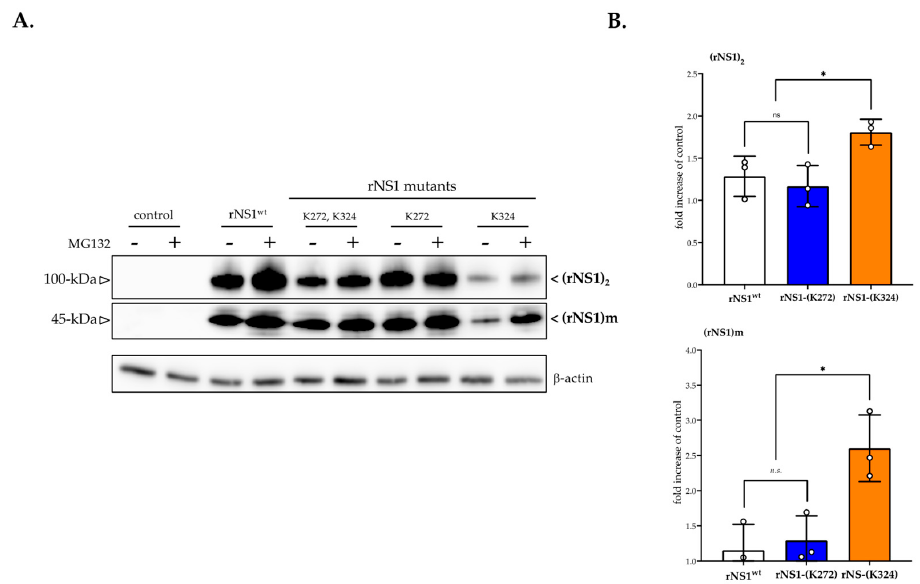
Figure 3. Effect of proteasome inhibition on DENV-2 rNS1 expression. Huh7 cells were transfected for 24 h with plasmids expressing DENV-2 rNS1 wt or rNS1-(K272), rNS1-(K324), and rNS1-(K272, K324) mutants or mock-transfected (control) in presence (+) or absence of 10 μ M of the proteasome inhibitor MG132 in 0.1% DMSO for 6 h. In ( A ), immunoblot assays were performed on RIPA cell lysates using anti-NS1 antibody. Cell lysates were analyzed before (top) and after (bottom) heat-denaturation in the presence of a reducing agent. The mouse anti-NS1 antibody D/2/D6/B7 (anti-NS1 mAb) was used to detect heat-labile dimer rNS1 which is indicated as (NS1) 2 . The rabbit anti-NS1 antibody PA5-33207 (anti-NS1 pAb) was used to detect monomeric form of rNS1 which is indicated as (rNS1)m. The β -actin protein served as a protein loading control. The estimated apparent molecular weights of (rNS1) 2 and (rNS1)m are indicated. In ( B ), signal intensity was quantified using ImageJ software to calculate the fold-increase between the amounts of rNS1 expressed with or without MG132 (control). The results are the mean (± SEM) of 3 replicates (open circles). p -values were determined on the comparison of different rNS1 (* p < 0.05; n.s. : not significant).